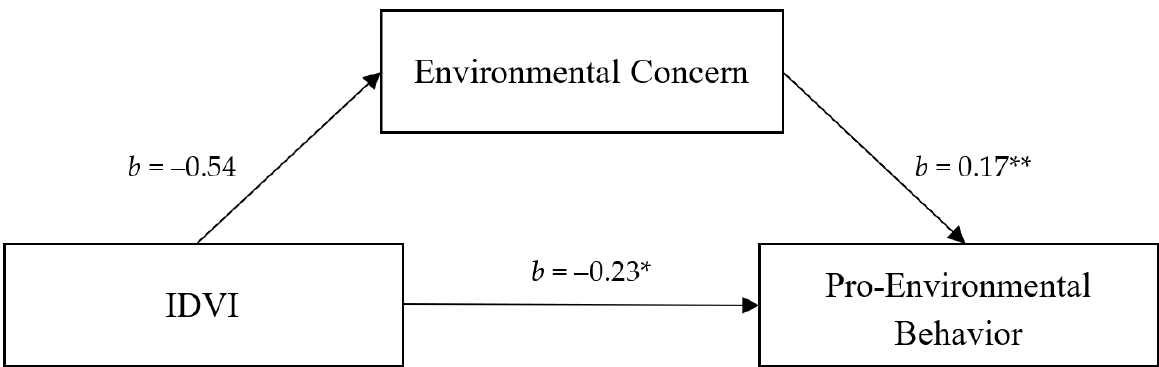
Figure 1. Note. Reported are standardized regression coefficients and standardized indirect effect with bootstrapped 95% confidence interval, ** p < 0.01, * p < 0.05.